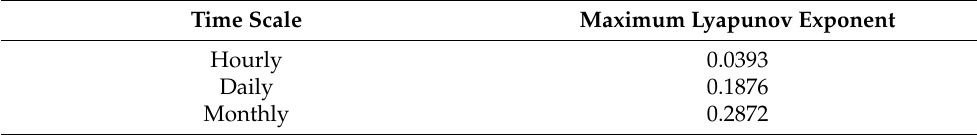
Table 4. The maximum Lyapunov exponent of the EDH time series at the different timescales. Time